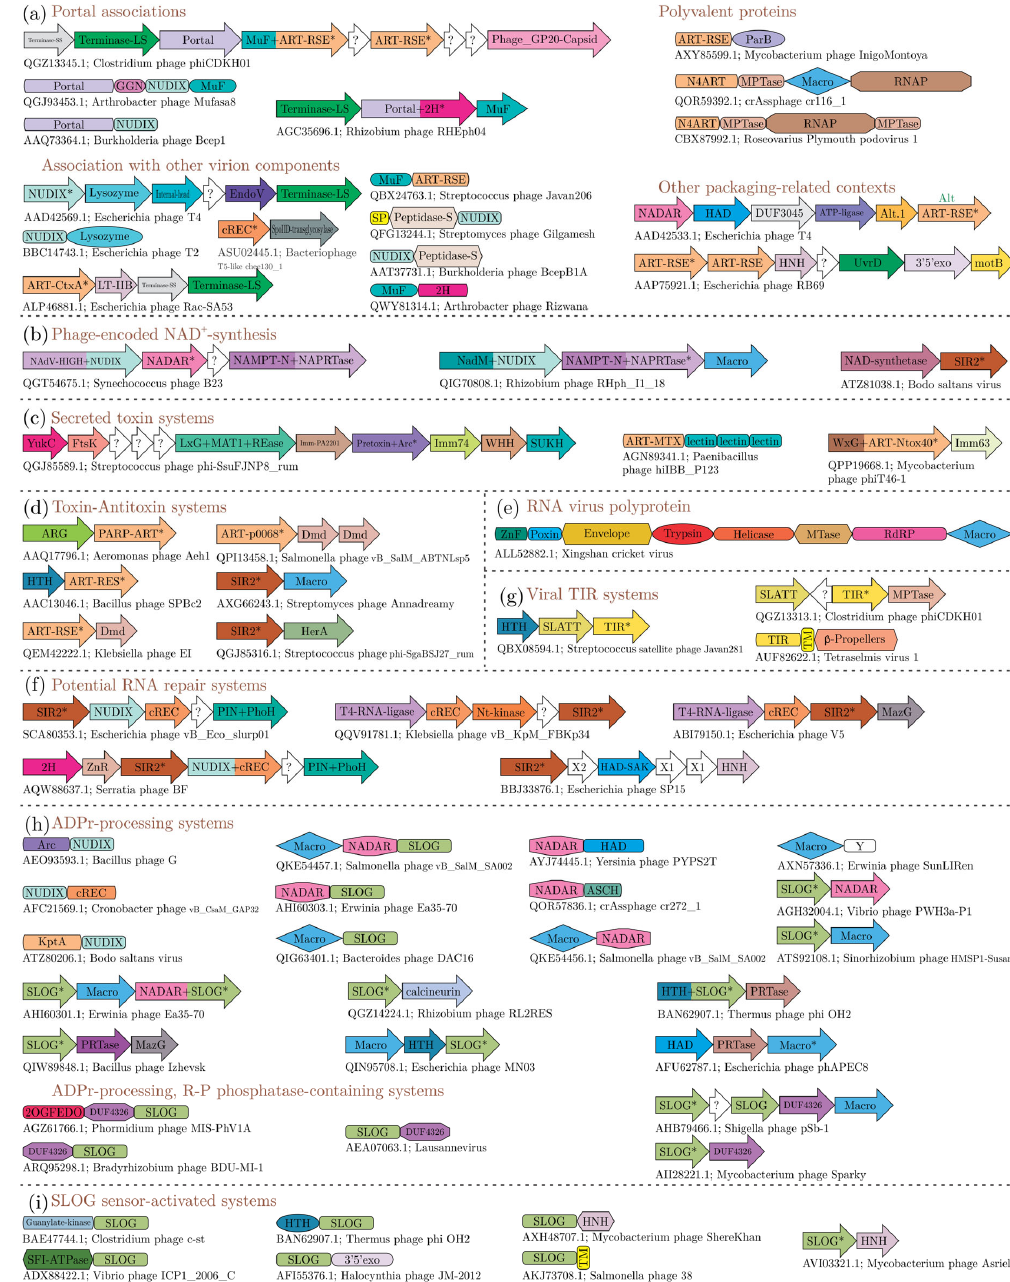
Figure 5. Representative contextual associations including domain architectures and gene neigh ‐ borhoods of various domains of the NAD + –ADPr network. Gene neighborhoods are shown as box arrows with the arrowhead pointing to the 3 ′ gene. Domain architectures are shown by other shapes. The contextual associations are categorized based on their genomic contexts or their function in ‐ cluding ( a ) domains associated with the Terminase ‐ portal genes and those encoding other virion components; ( b ) domains involved in NAD + synthesis; ( c ) secreted toxin domains; ( d ) domains that are components of T–A and related conflict systems; ( e ) domains in RNA virus polyproteins; ( f ) domains involved in a predicted RNA repair system; ( g ) viral TIR systems; ( h ) domains involved in ADPr ‐ processing and; ( i ) SLOG sensor ‐ activated systems. Gene neighborhoods are labeled with the accession number and species name of the gene marked with an asterisk.